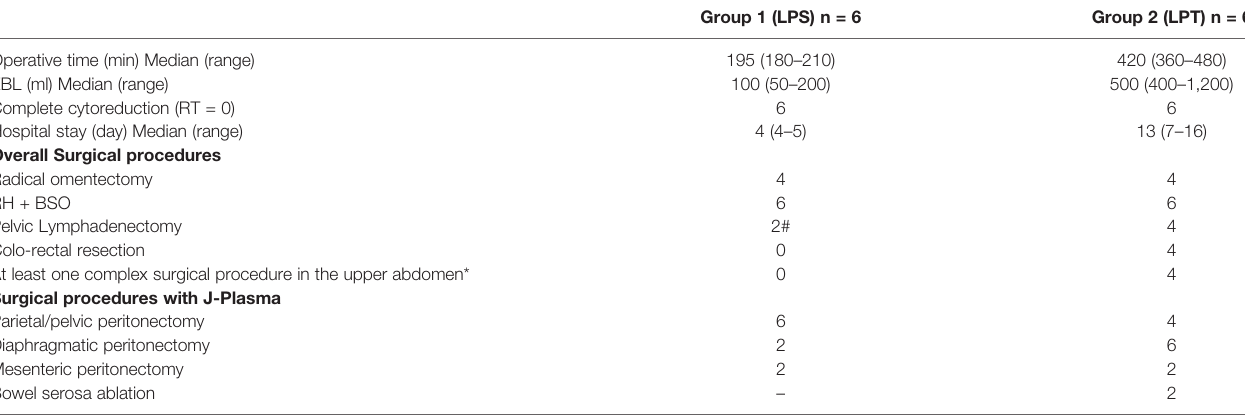
TABLE 2 | Perioperative variables and J-Plasma assisted surgical